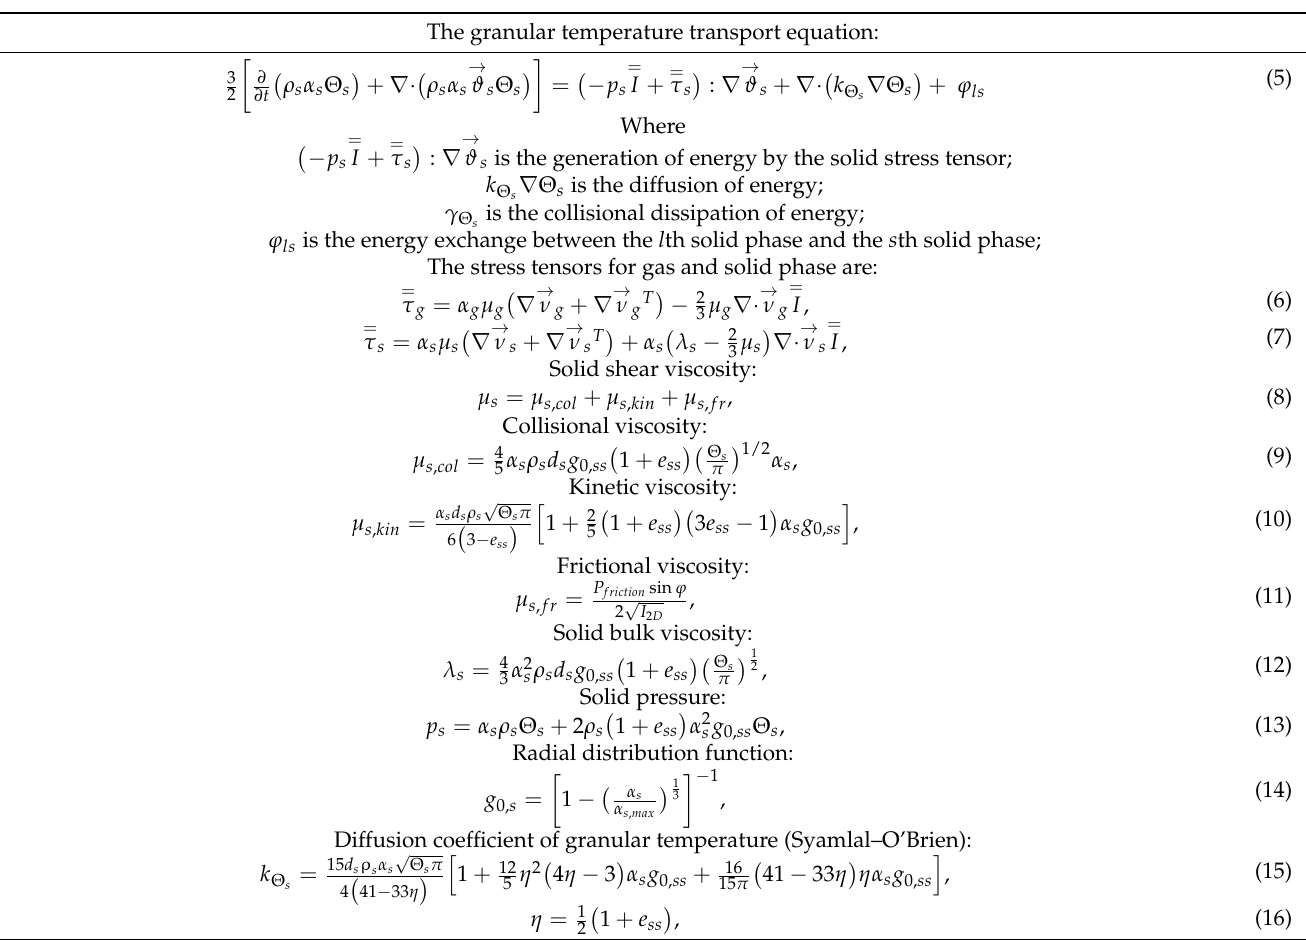
Table 2. Constitutive equations.